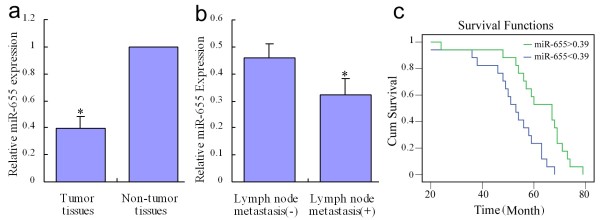
miR-655 expression in ESCC tissues and adjacent non-tumor tissues. (a) The relative expression levels of miR-655 in paired ESCC tissues and adjacent non-tumor tissues were determined by qRT-PCR. A statistically significant difference in expression levels (P < 0.05) was observed. (b) qRT-PCR results showing that miR-655 expression in the metastasis-positive group was notably lower than in the metastasis-free group (P < 0.05). (c) Kaplan–Meier curves of the clinical outcome for miR-655. Primary ESCCs with moderate to strong miR-655 expression (>0.39) had significantly better survival than did those with weak miR-655 expression (<0.39) (P < 0.05, log-rank test). T: tumor tissue (n = 34); N: adjacent non-tumor tissue (n = 34). *P < 0.05 compared to the control group.